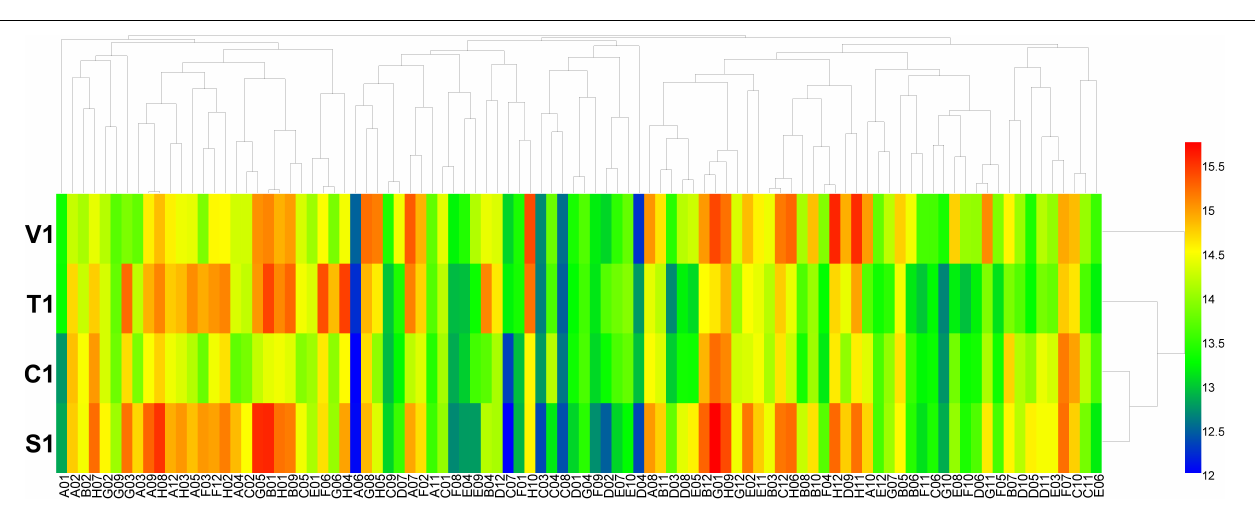
B. cinerea isolate from tomato exhibited the highest amino acid nitrogen substrate